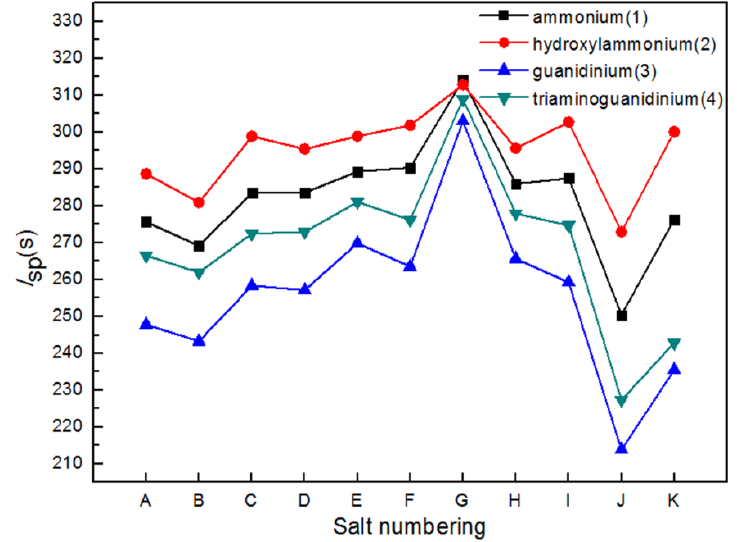
Figure 5. Comparison of the specific impulses ( I sp ) of ammonium-based 4,8-dihydrodifurazano[3,4- b , e ]pyrazine-based salts.